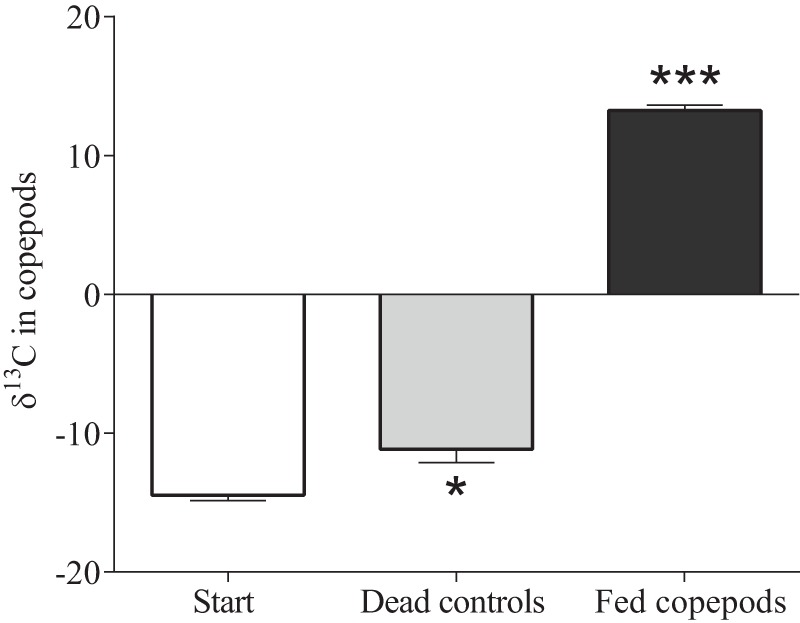
Carbon uptake from 13C-labeled Synechococcus bacillaris by the copepod Acartia tonsa (live and dead individuals) exposed to the picocyanobacterium (Experiment III).Carbon uptake is expressed as change in δ13C of the copepods from the start values. Differences between the start and each treatment group are shown by asterisks (*: p<0.05; ***: p<0.0001). Data are shown as mean ± SD, n = 3 in all cases.